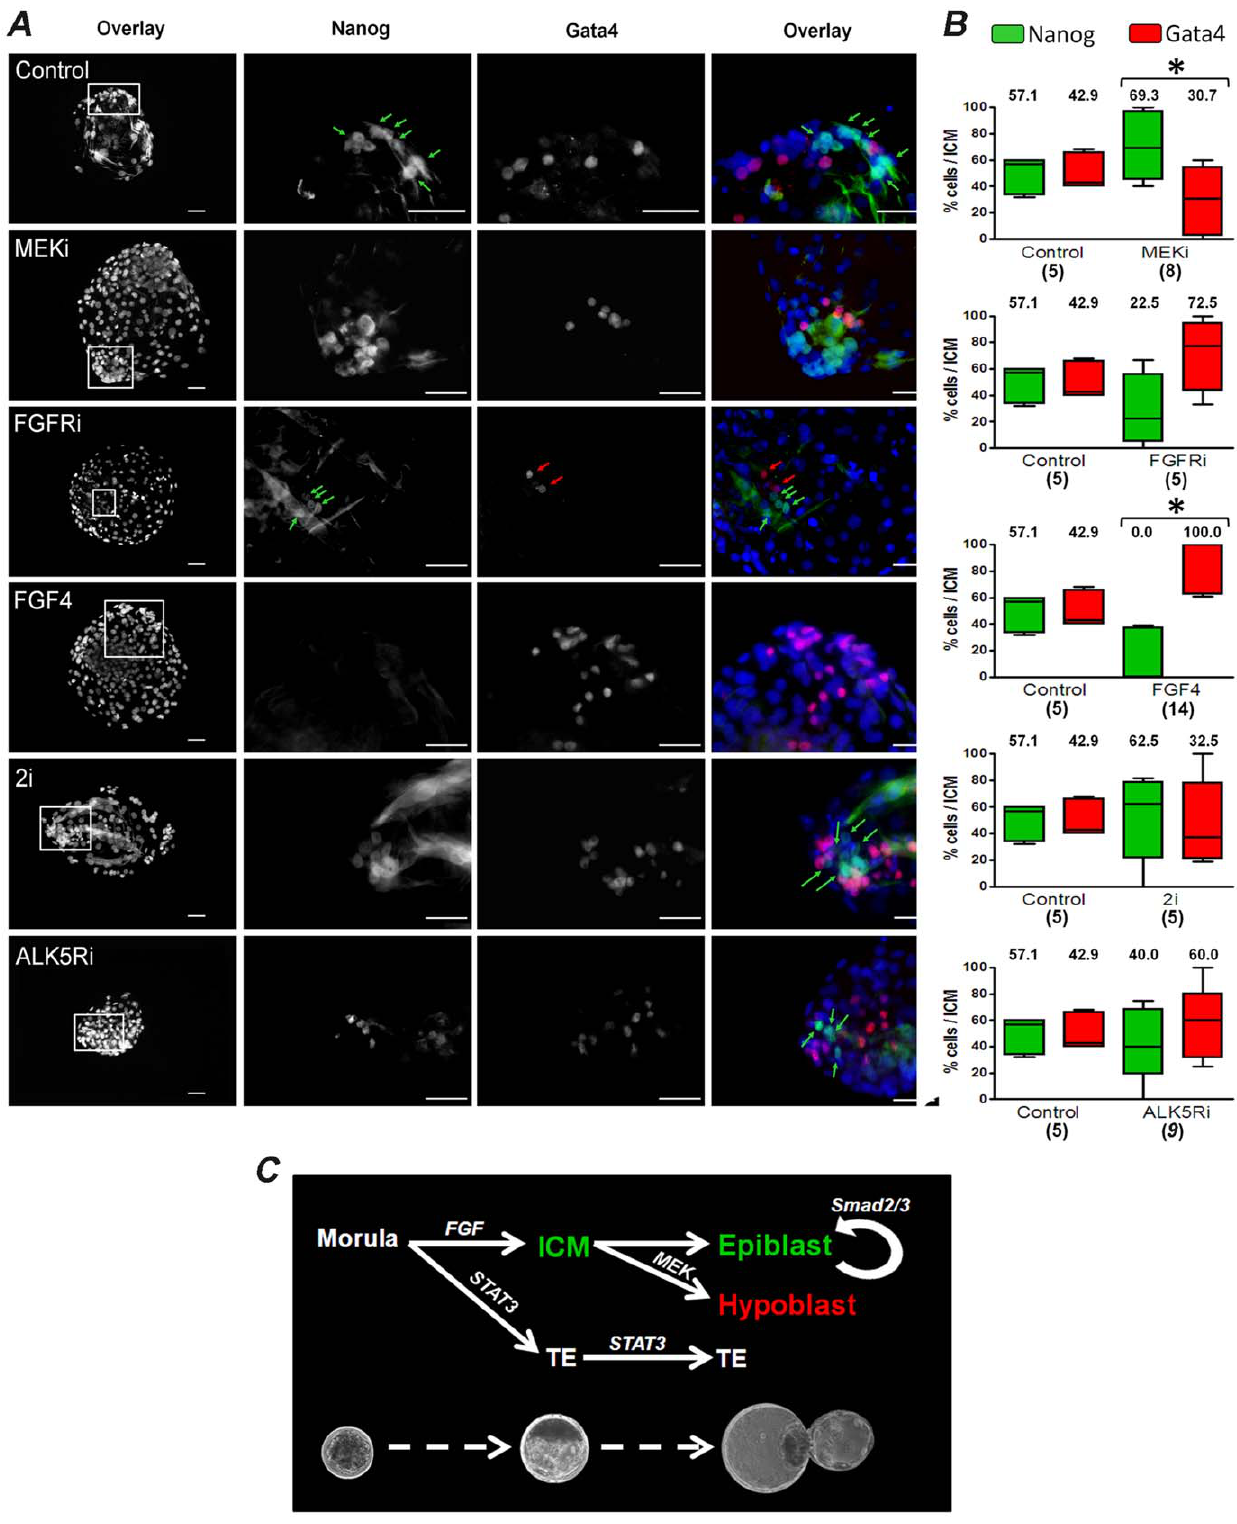
Figure 2. Effect of signalling inhibition in lineage segregation. A) Immunofluorescence images of NANOG and GATA-4 of hatched blastocysts after incubation with the indicated molecules from the morula stage. Blue: nuclei stained with DAPI. Scale bar: 50 m m. B) Box-whisker plots depicting the proportion of NANOG (green) and GATA-4 (red) cells of embryos treated with different molecules. Numbers indicate median values for each group. * P , 0.05. C) Model depicting the stages of embryo development studied in this report. Inhibition of STAT3 signalling interferes with the cavitation process affecting the development of the ICM and the TE during the transition from early to late blastocyst. In addition, inhibition of FGF receptors at the morula stage prevents the formation of the ICM, whereas inhibition of MEK signalling reduces, but does not totally abolish, the